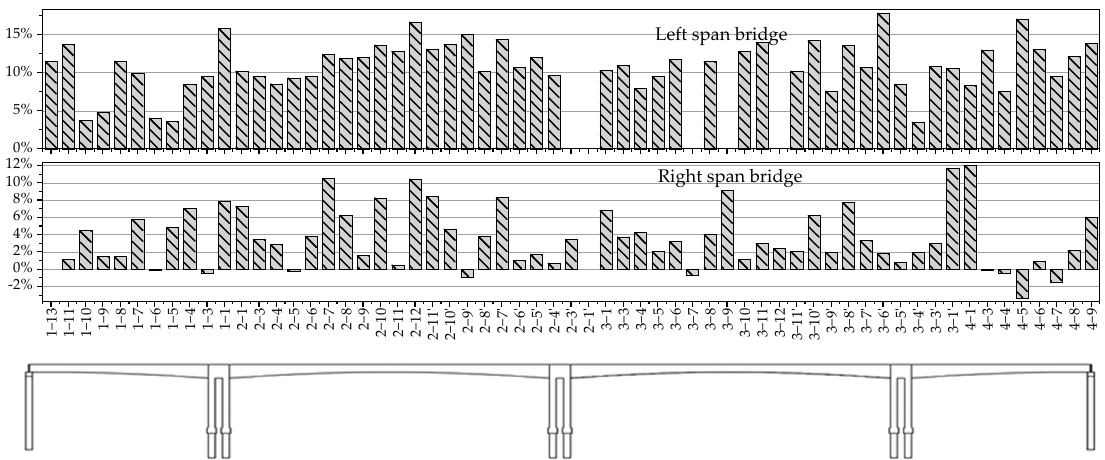
Figure 10. Deviation-rate bar chart of bridge A cross sections.